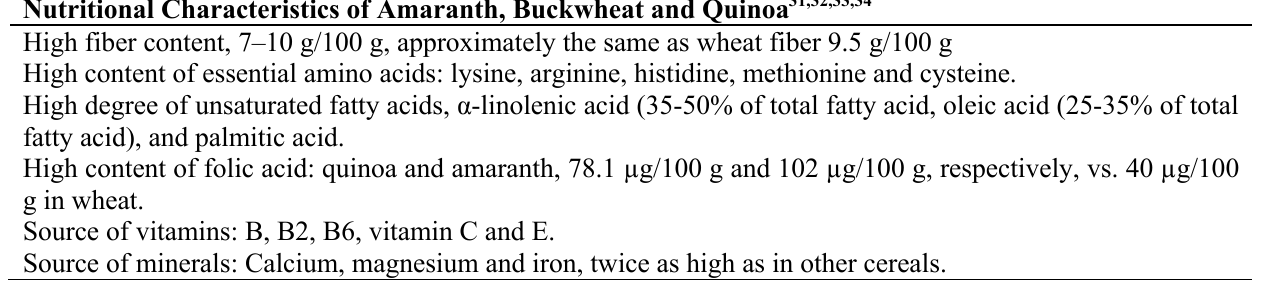
Table 3 . Nutrition requirement of particular concern 35